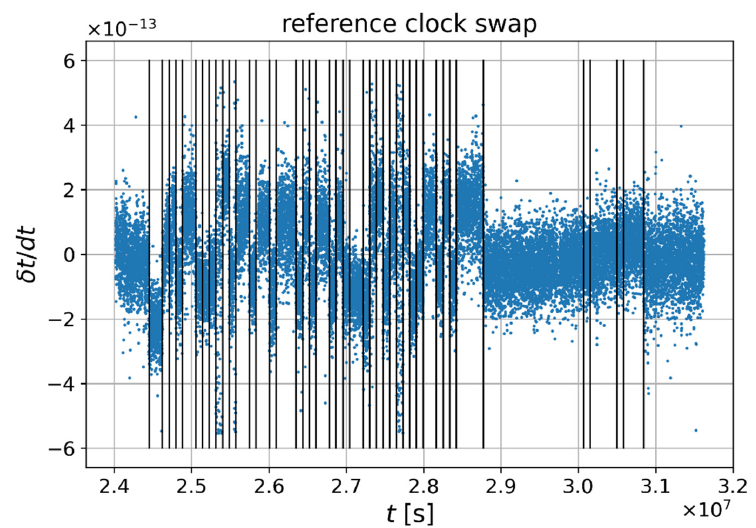
Figure 4. Reference clock for the WUM clock product swapping. Vertical black lines indicate the instant of reference clock switch.